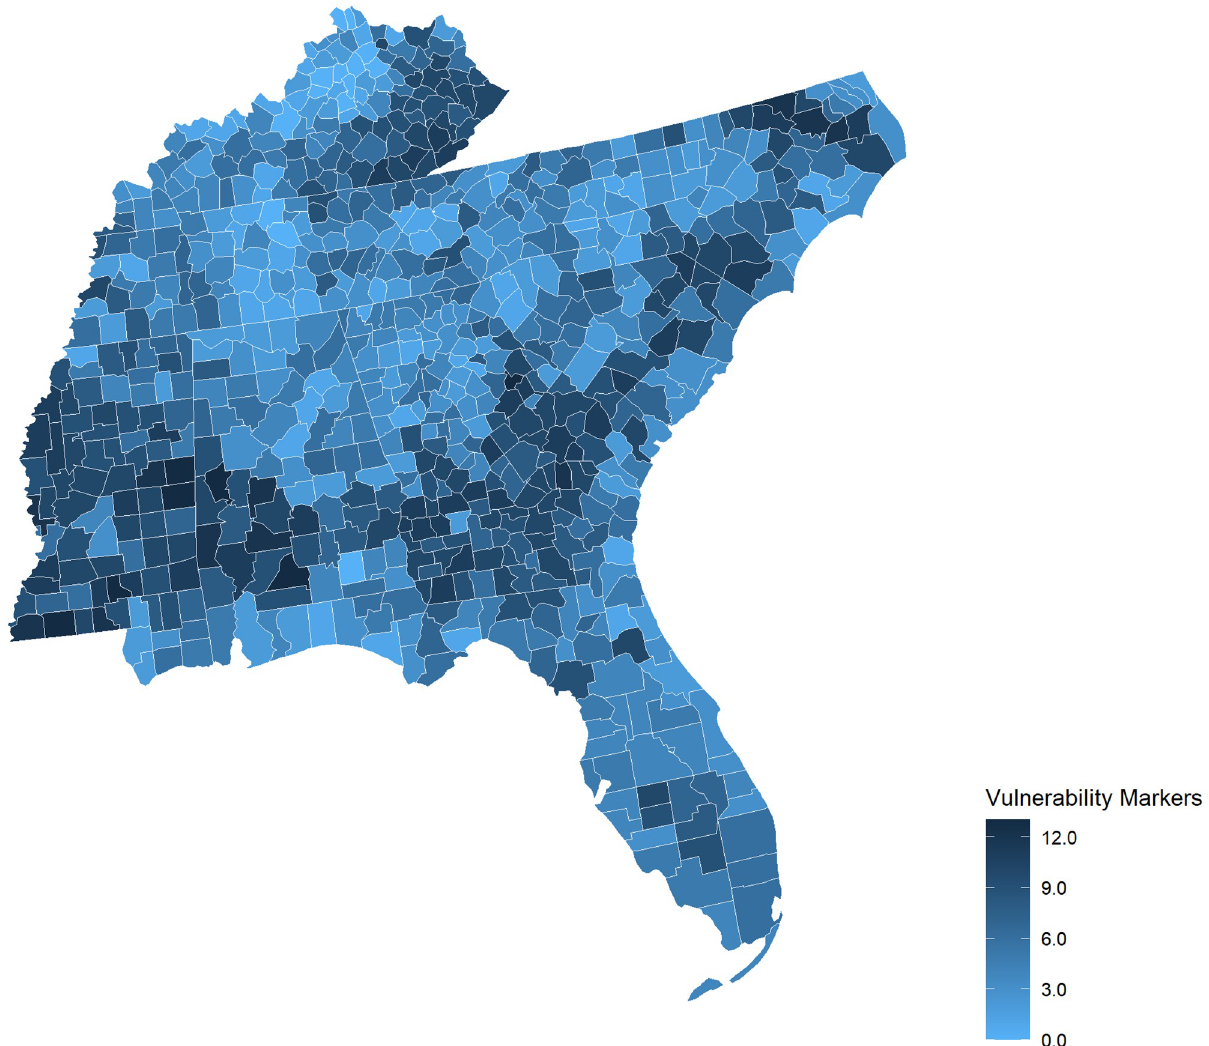
Fig 2. Markers of medical, economic, and geographic vulnerability, HHS Region 4, 2017 Alabama, Florida, George, Kentucky, Mississippi, North Carolina, South Carolina, Tennessee. Map prepared using R’s open source package, usmaps, developed by Paolo Di Lorenzo under a GNU